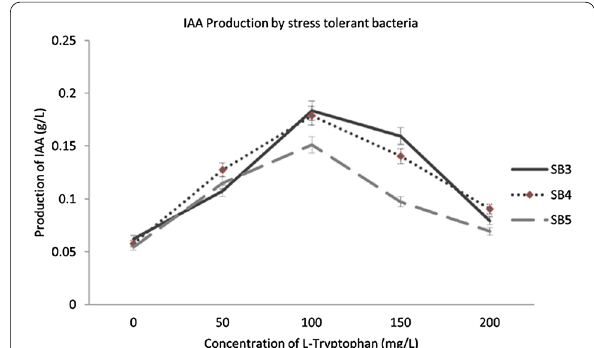
Fig. 4 Effect of L-Tryptophan on production of IAA by different types of stress-tolerant bacteria. Results represented as mean